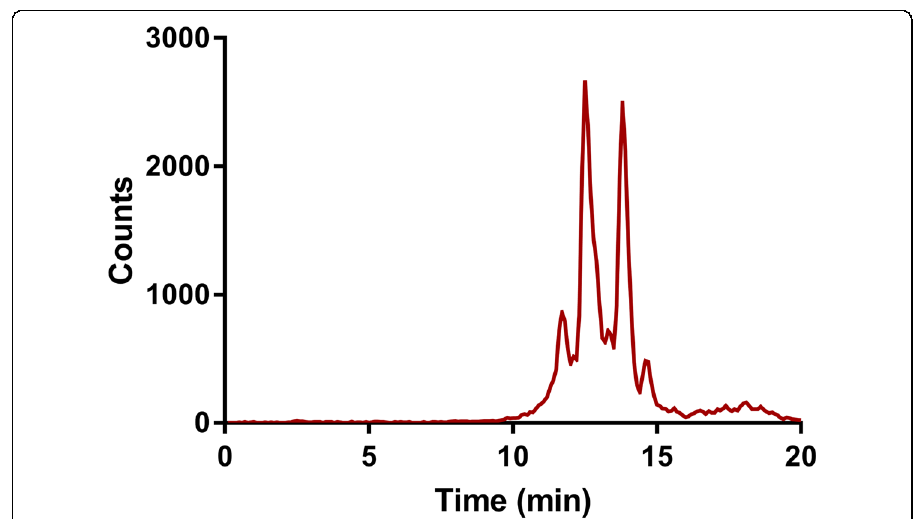
Fig. 4 High performance liquid chromatography (HPLC) chromatogram of the radiodetector. The retention time of unbound [ 99m Tc]pertechnetate is 2.5 min. The retention time of [ 99m Tc]Tc-PSMA is between 10 and 15 min, with different peaks accounting for different protonation